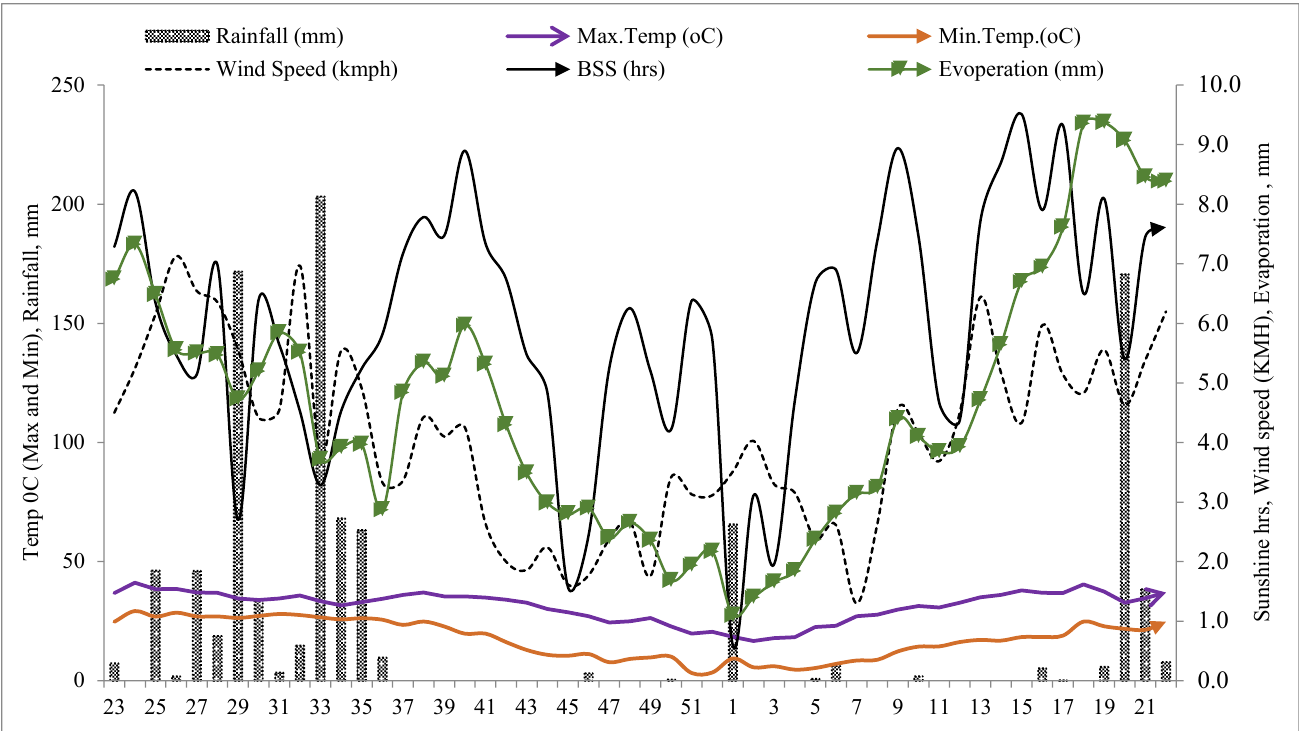
Figure 1. Weekly meteorological data for the cropping season.